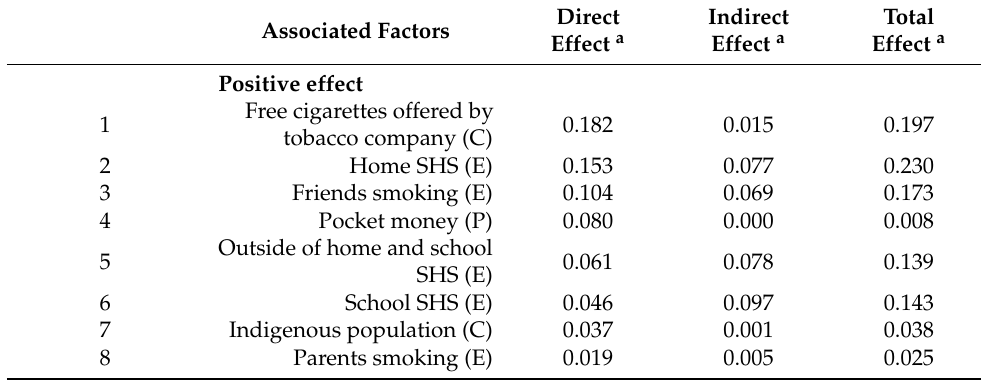
Table 3. Direct, indirect, and total effect of associated factors on current cigarette smoking